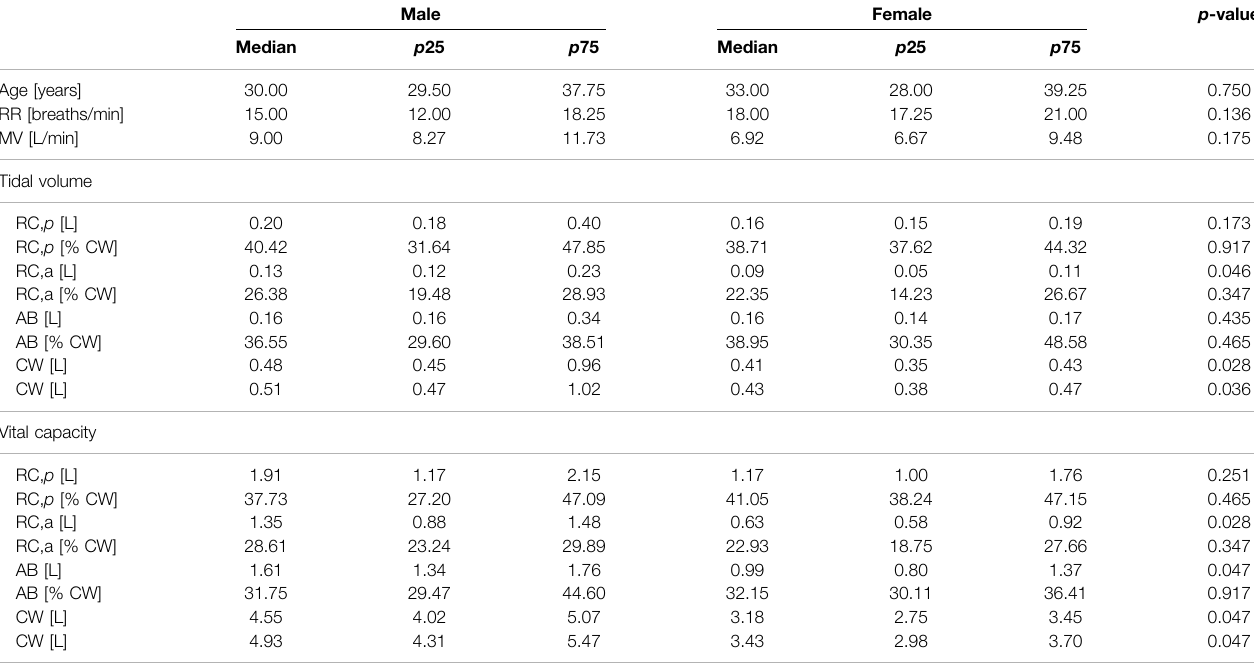
TABLE 1 | Age and breathing pattern.